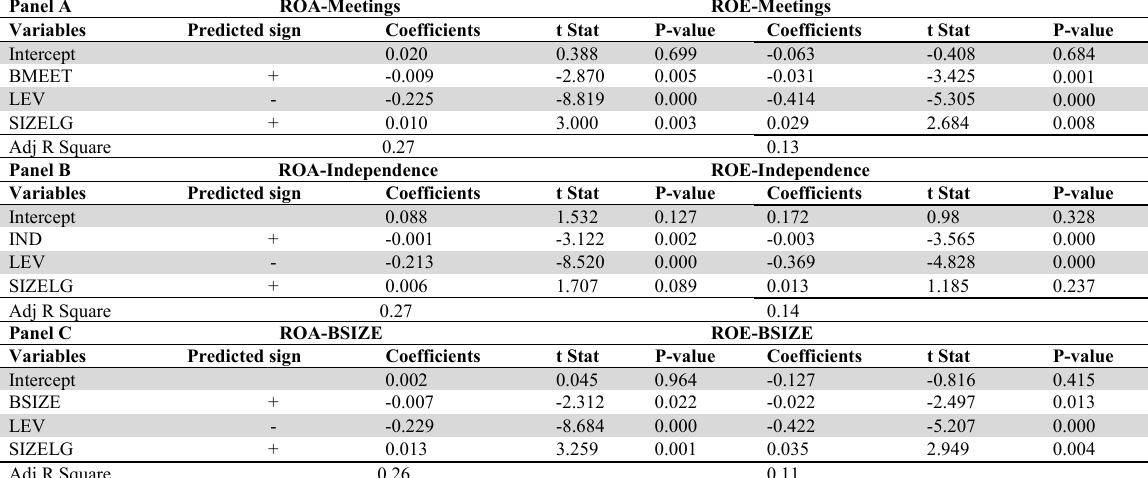
Pooled OLS Results of BC and Performance. Panel A Meetings and Performance (ROA & ROE) Panel B Independence and Performance (ROA & ROE). Panel C BSIZE and Performance (ROA &